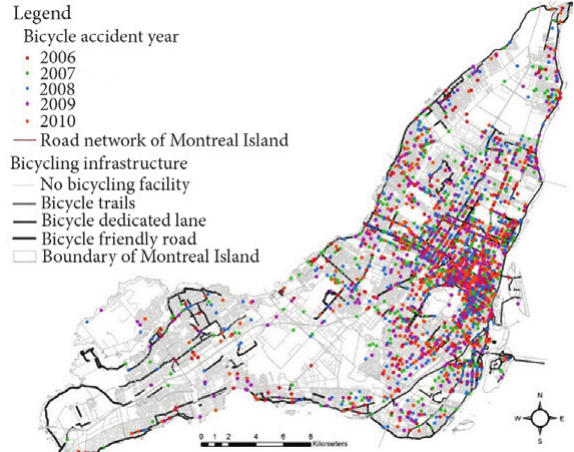
Fig. 1. Bicycle path and bicycle-related accidents from 2006 to